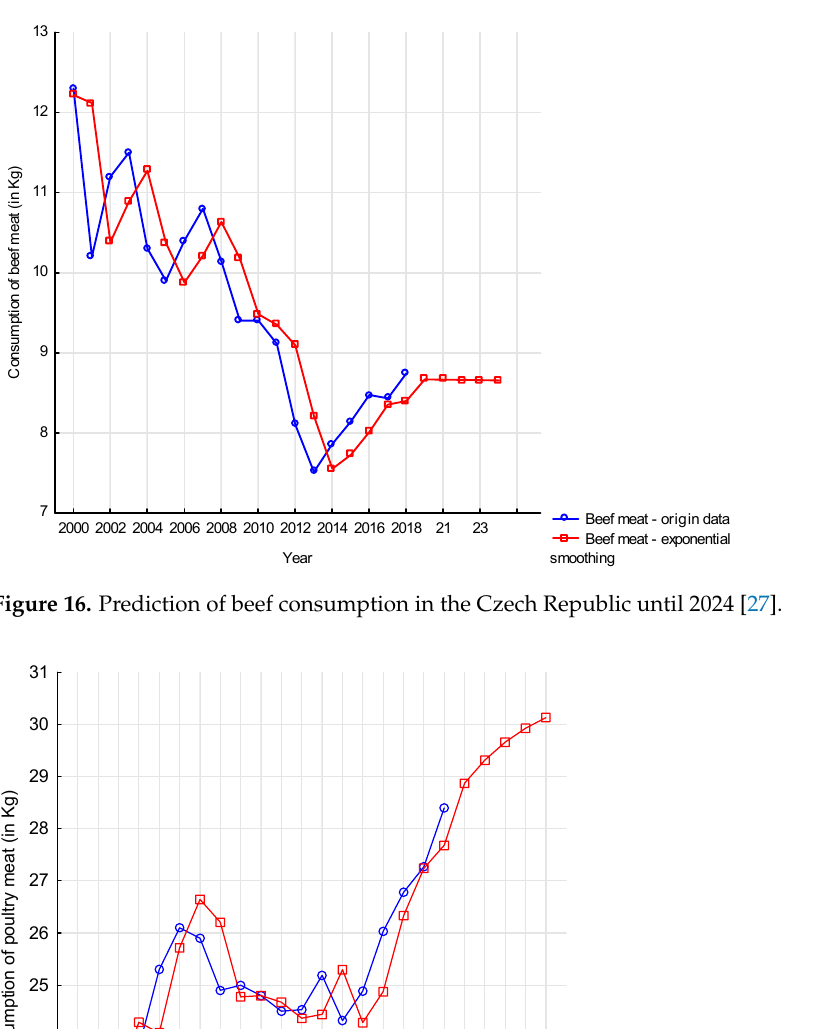
Figure 15. Prediction of pork consumption in the Czech Republic until 2024 [27].